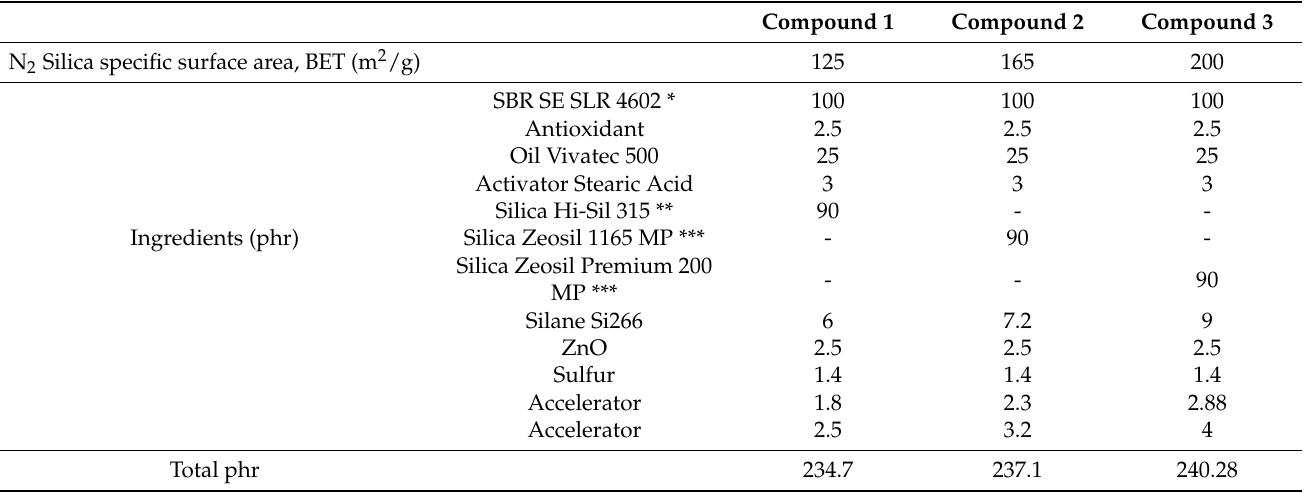
Table 1. Compound